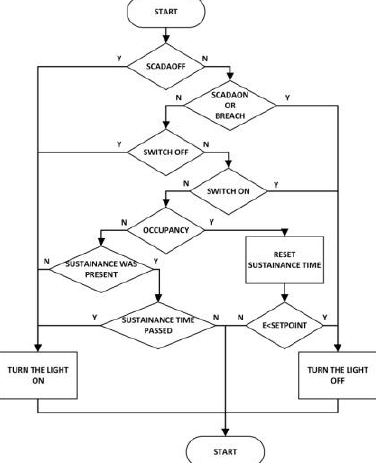
Fig. 1. Lighting control algorithm in rooms